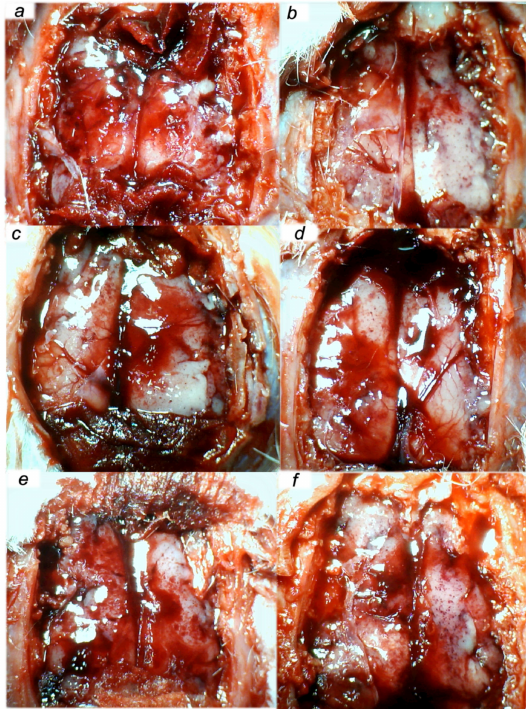
Figure 11. Timeline of the brain swelling and brain swelling counteraction. Brain swelling gross in vivo presentation ( a – f ) (first lithium application ( a , control), ( b , BPC 157), second lithium ap- plication ( c , control), ( d , BPC 157), third lithium application ( e , control), ( f , BPC 157)). Marked swelling was found in controls after each of the lithium administrations. Contrarily, lithium rats that received BPC 157 regimens presented counteraction of the brain swelling after each of the lithium